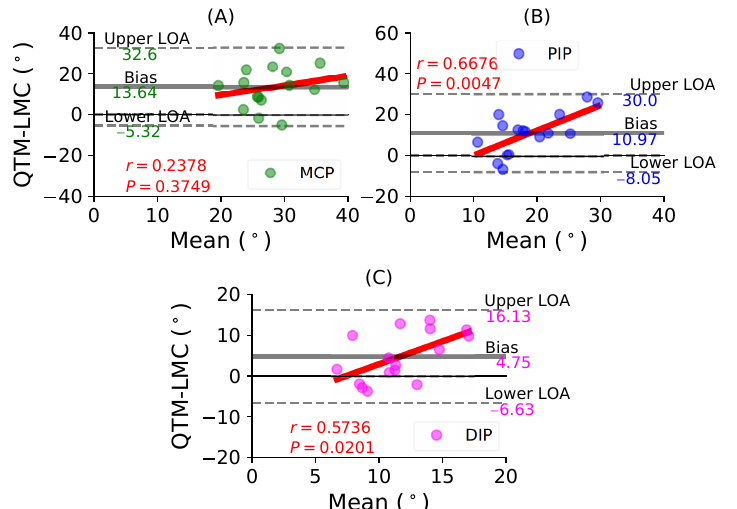
Figure 10. A BA plot of pinky finger flexion. ( A ) MCP joint comparison, ( B ) PIP joint and ( C ) DIP